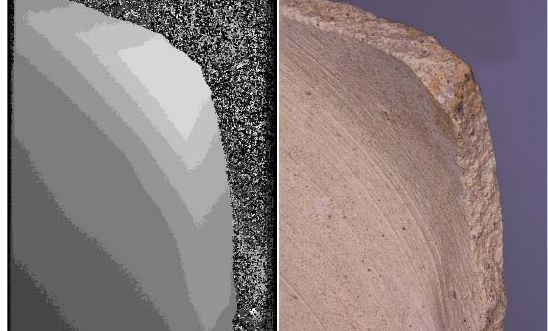
Figure 2: Compiling photos based on stacked focus create a depth map (left); and a final fully-focused image (right)